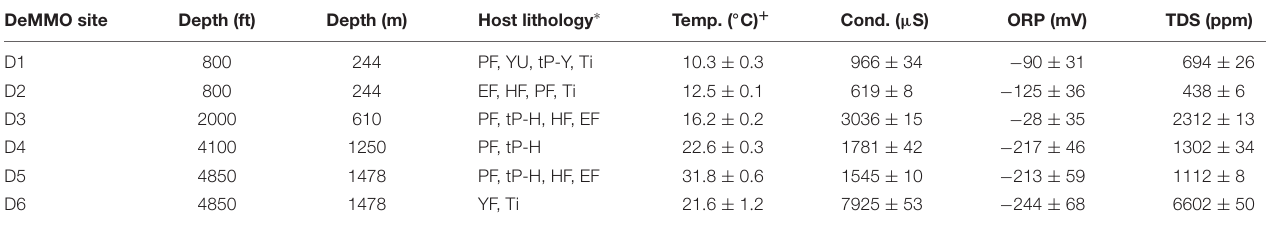
TABLE 1 | Site characteristics of DeMMO and surrounding rocks. DeMMO